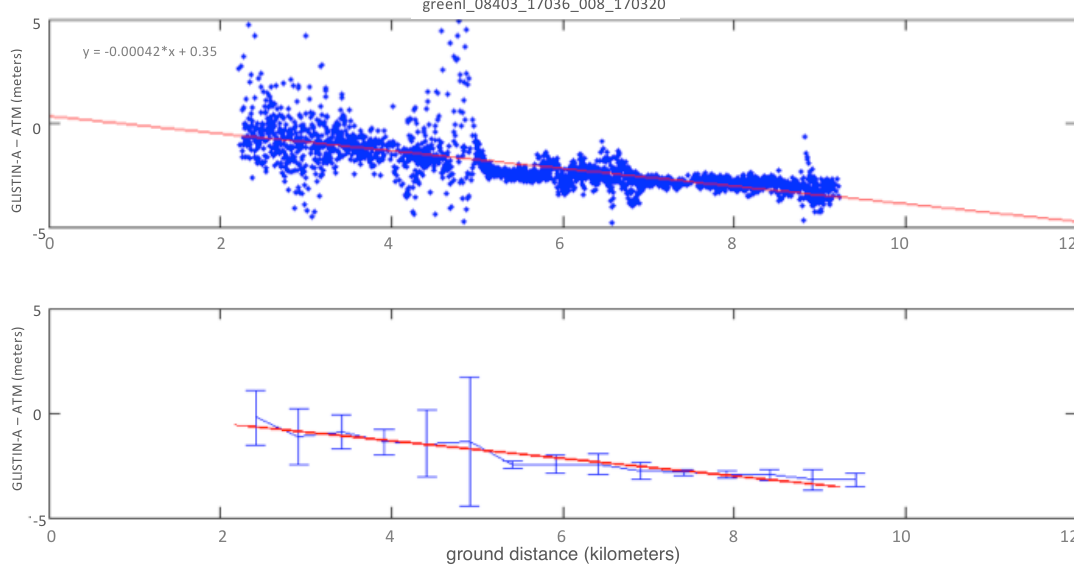
(kilometers) ground distance (kilometers) Figure 7. Upper plot : An example least-squares linear fit of GLISTIN-A to ATM data as a function of the cross-track distance. Lower plot : The mean and standard deviation of the height difference data compared with the linear fit above. The height difference data is binned into 500 m bins across track and the statistics for each bin is calculated. The binned means follow the linear trend well. The standard deviation is an indication of both spatial variability/dynamics and the instrument precision. For x < 5000 m it is apparent that there is an influence of surface dynamics, but the fine precision further out indicates a static surface and excellent instrument